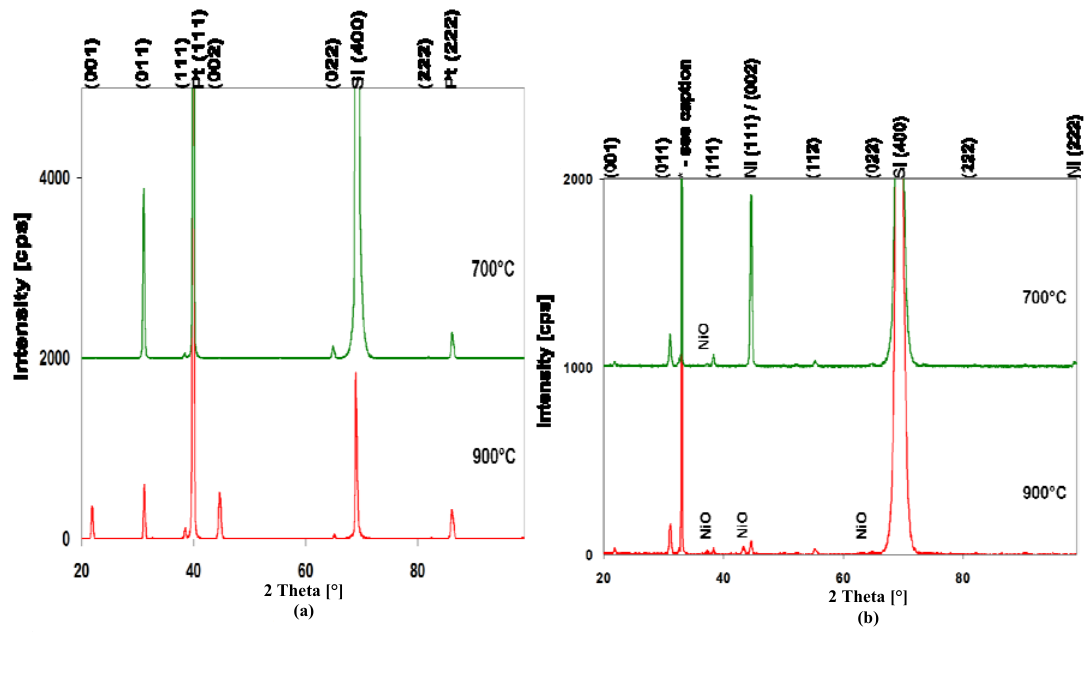
Figure 6. θ –2 θ XRD pattern (Cu K α radiation) of BCZTO films deposited onto: (a) Pt (111) and (b) Ni (111) bottom electrodes at 700 °C (upper traces) and 900 °C (lower traces) (10 mtorr pressure, 10% O in Ar, Si (100) substrate in all 2